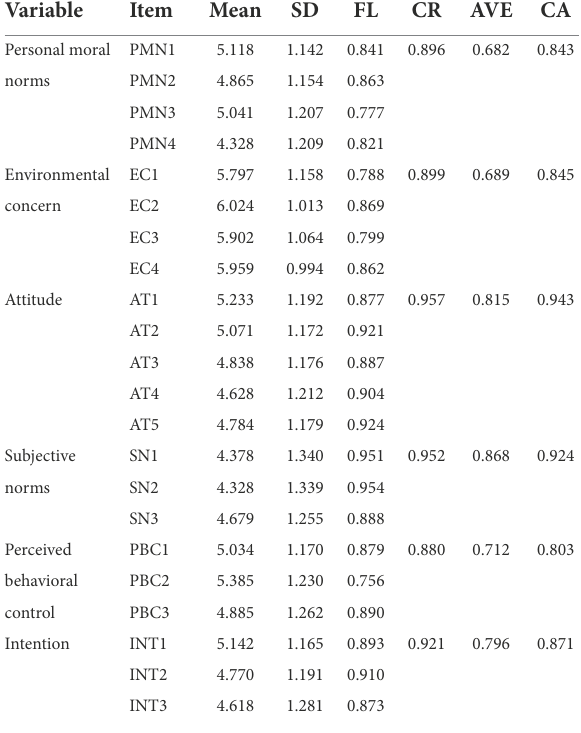
Table 4. AT significant positive impact INT ( β = 0.525, T = 7.210,